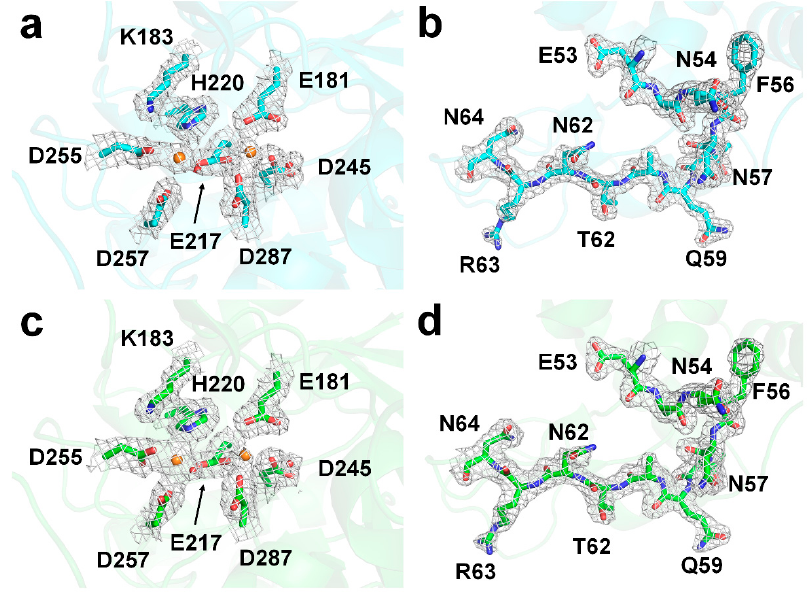
Figure 4. 2Fo-Fc electron density map (grey mesh, 1.2 σ ) of the active sites of ( a ) glucose isomerase and ( b ) lysozyme delivered in WS (cyan), and ( c ) glucose isomerase and ( d ) lysozyme delivered in alginate (green).